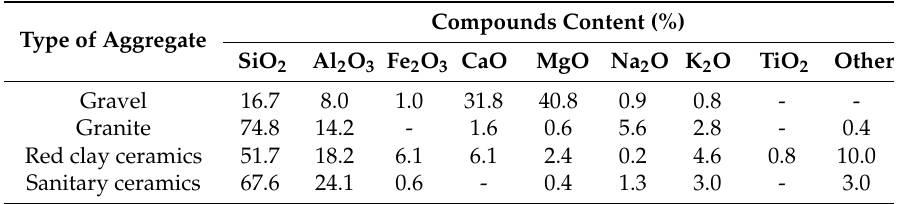
Table 3. The comparison of chemical content of selected concrete aggregates.